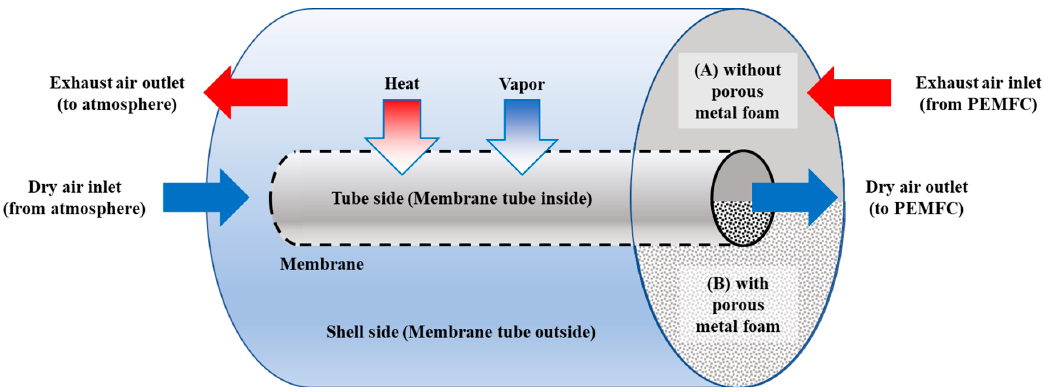
Figure 1. Layout of the shell-and-tube membrane humidifier without porous metal foam ( A ) with porous metal foam ( B ).